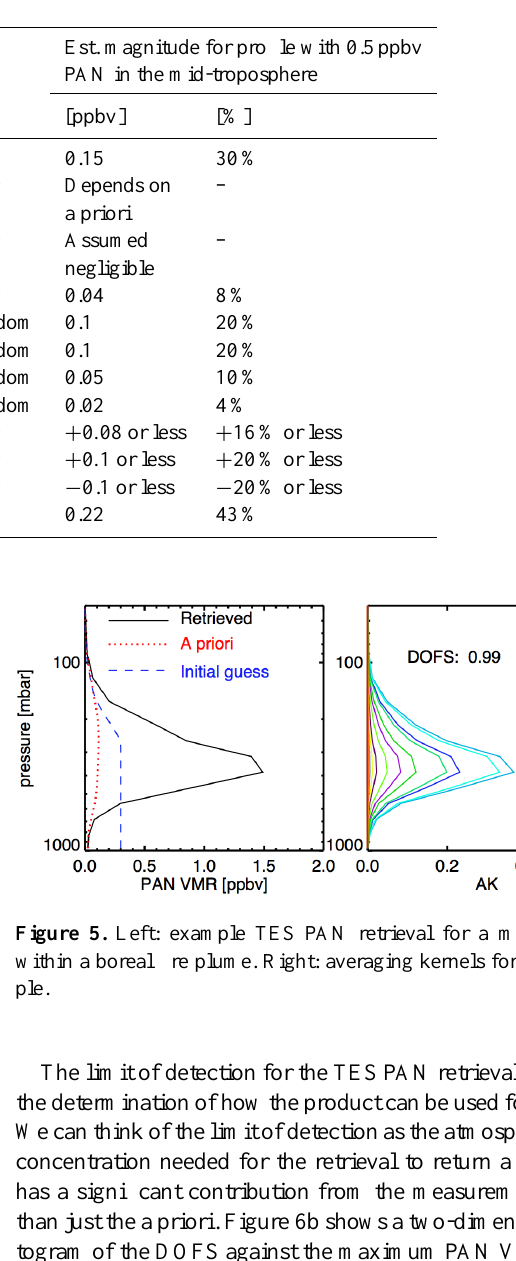
Table 2. Sources of uncertainty in TES PAN retrievals.